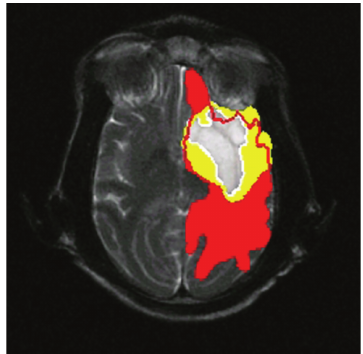
Figure 4: Overlapped imaging shows infarcted core (white), IP (yellow), and oligemia (red).